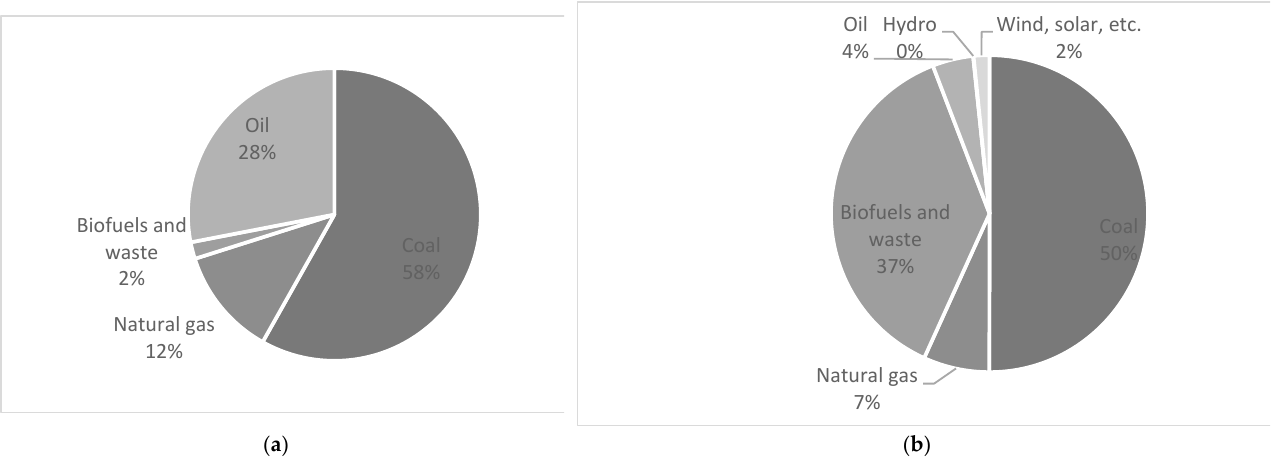
Figure 9. Structure of energy supply in Estonia: ( a ) 1990; ( b ) 2020. Source: authors’ compilations based on database of the International Energy Agency.